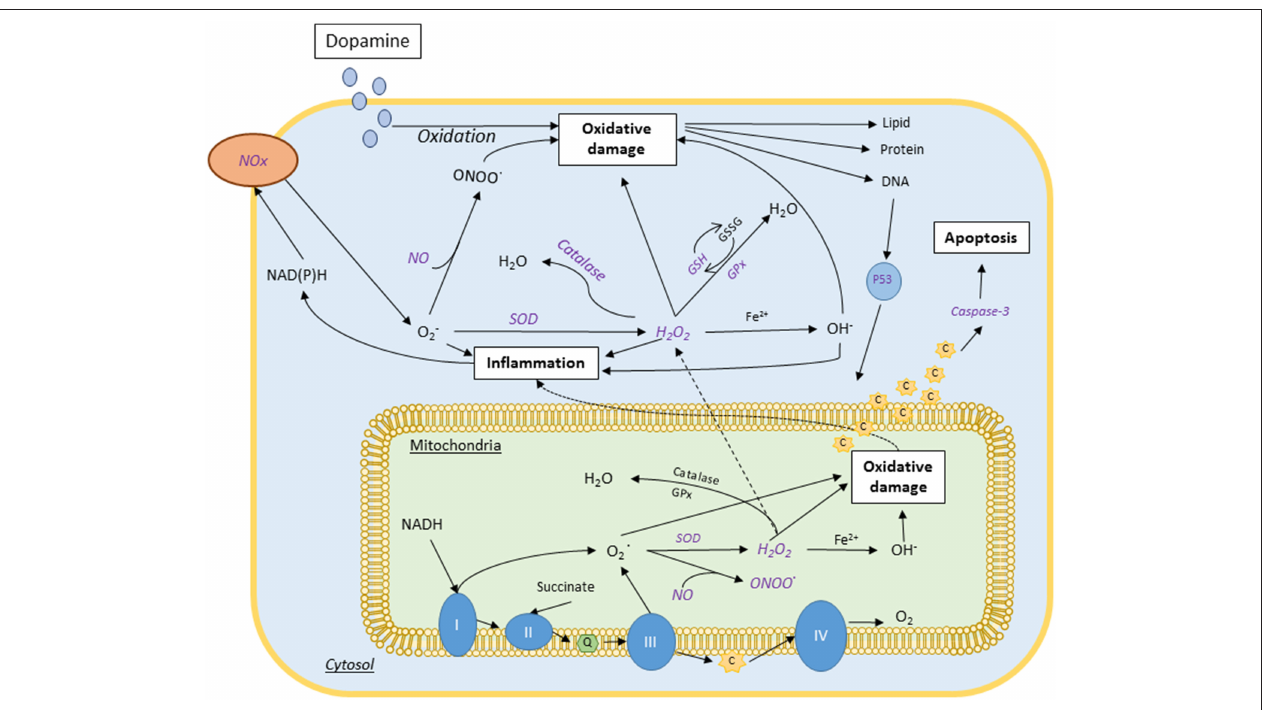
FIGURE 1 | Proposed neurobiology of bipolar disorder and schizophrenia and associated mechanisms of mangosteen pericarp (purple italics). These major psychiatric disorders have been shown to have aberrations in oxidative biology, mitochondrial function and neurogenesis/apoptosis. The purple italicized text indicates the points at which mangosteen pericarp has mechanistic actions that may benefit these disorders. Complexes I, II, II, and IV; CoQ, Coenzyme Q; C, cytochrome C; Fe 2 + , ferrous ion; GPx, glutathione peroxidase; GSH, reduced glutathione; GSSG, oxidized glutathione; H 2 O , water; H 2 O 2, hydrogen peroxide; NADH, nicotinamide adenine dinucleotide (phosphate); NO, nitric oxide; Nox, NADH, Reduced Nicotinamide adenine; O2, Superoxide anion; OH, Hydroxyl radical; ONOO, peroxynitrite; SOD, Superoxide